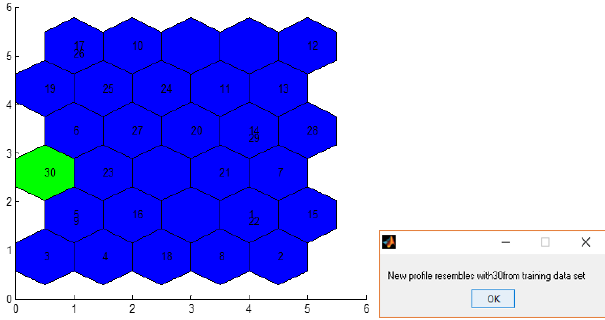
Figure 8. Best matching unit of SOM in the testing phase.